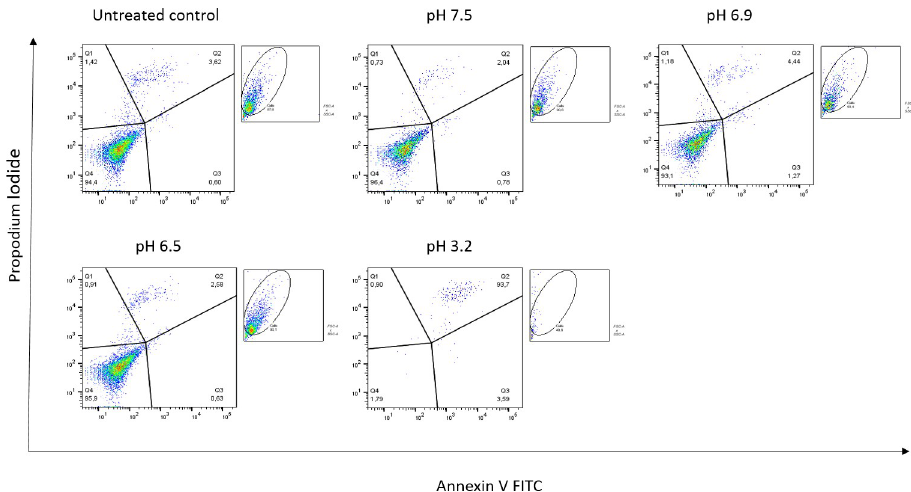
Fig 3. Decreasing pH causes cell death in SNO cell